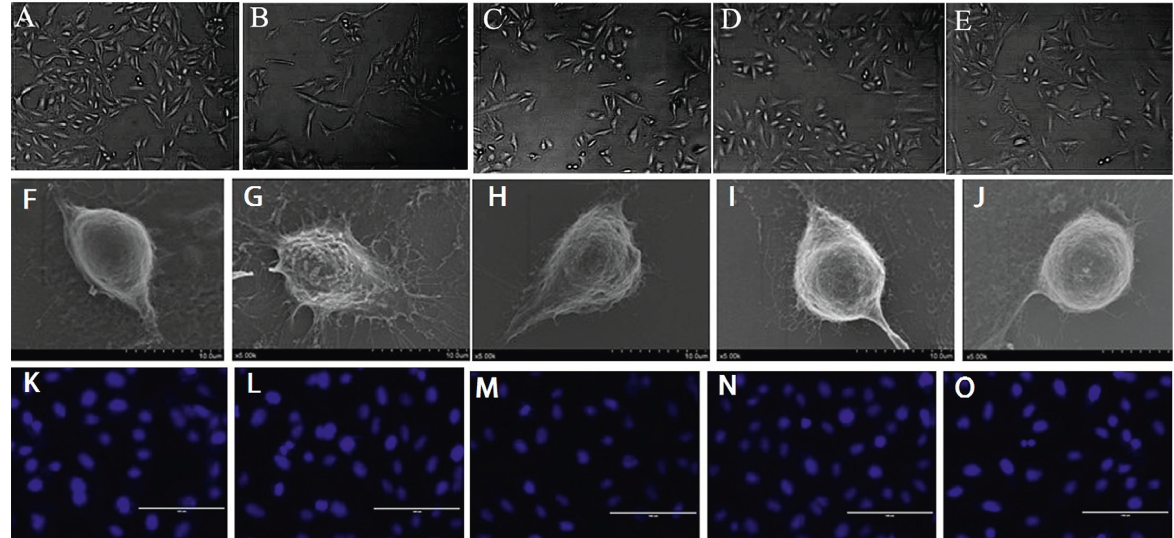
Figure 4: Observation of A549 cell morphology under inverted biological microscope ( × 100), scanning electron microscope ( × 5000), and fluorescence microscope ( × 400). (a, f, k) Control; (b, g, l) 200 μ mol/L acetaldehyde; (c, h, m) 40 μ mol/L L-Cys +200 μ mol/L acetaldehyde; (d,